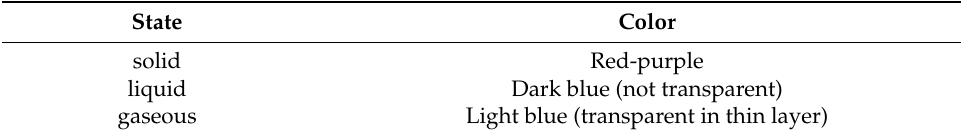
Table 2. Ozone colors in dependence on state properties